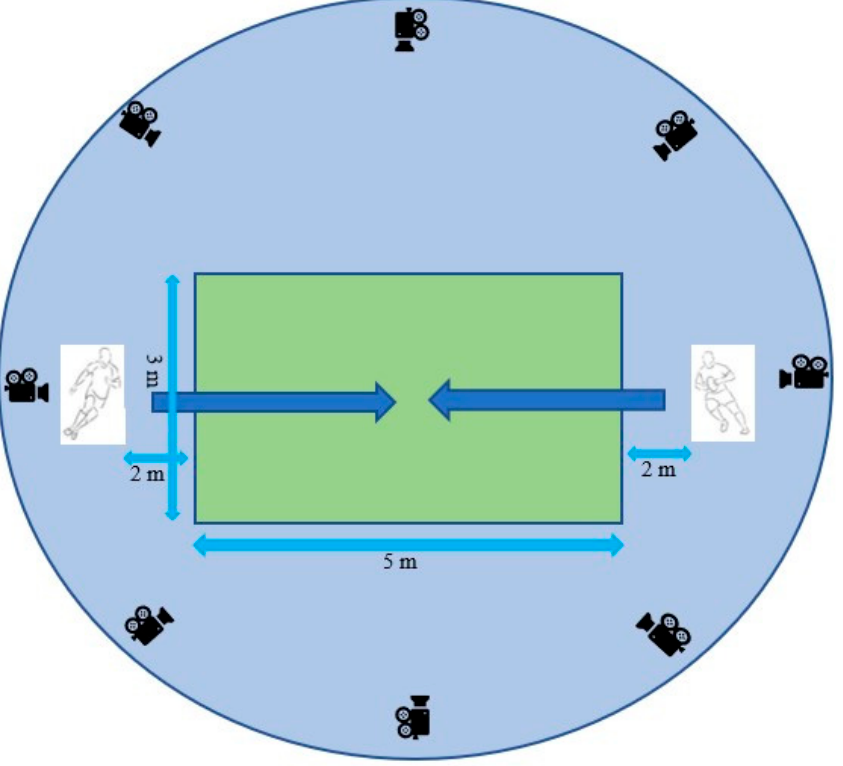
Figure 2. The laboratory layout for tackles. (Not all cameras shown). The ball carrier was instructed to try to get to the opposite side of the mats (shown in green) without going off the mats. The tackler was instructed to stop the ball carrier and bring him to the ground. Tackles were stopped if the ball carrier was not brought down within 5 s off tackle initiation.